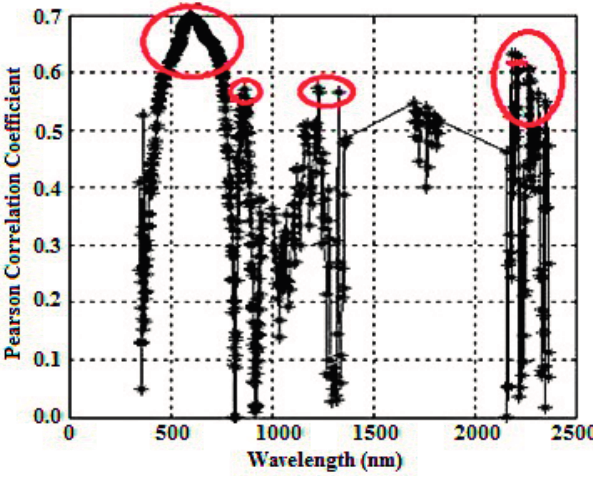
Figure 4. Correlation coefficient between different spectral bands and the Pb